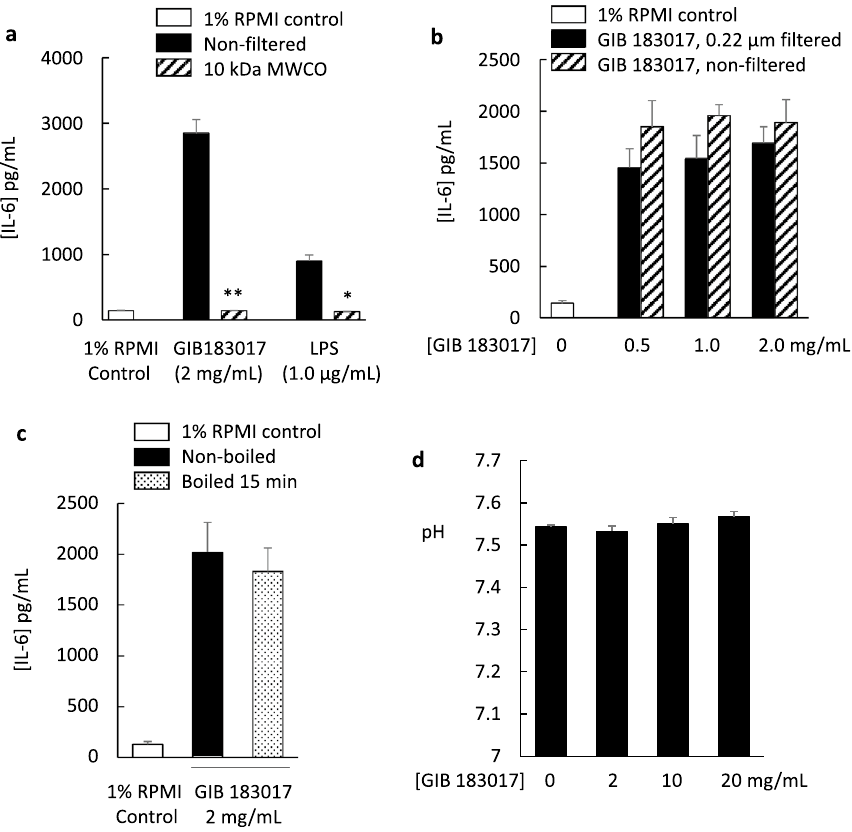
Figure 2. Characterisation of grey ironbark honey (183017) and lipopolysaccharide (LPS) for secretion of interleukin-6 (IL-6). Honey and LPS stimulated IL-6 secretion and this was prevented by ultrafiltration with a 10 kDa molecular weight cut-off spin filter ( a ) but not by filtration using a 0.22 µm syringe filter ( b ). The IL-6 secretory response was not affected by heat-treatment (boiled for 15 min) ( c ). pH was not appreciably affected by addition of the honey to the culture medium ( d ). Data are mean ± SEM; * p < 0.05, ** p < 0.01. ( a ) n = 3; ( b ) n = 3; ( c ) n = 3; ( d ) n = 4. Statistical analysis was performed using a Student’s t test ( a – c ) and a one-way ANOVA ( d